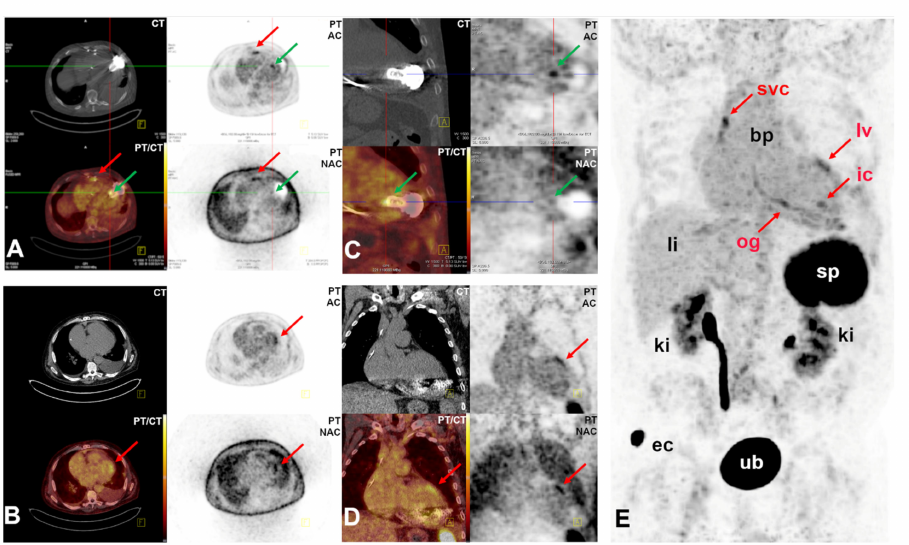
Figure 2. [ 18 F]GP1 PET/CT imaging findings of patient #2 with small thrombi in inflow cannula and outflow graft of the LVAD and residuum of thrombus adherent to the anterior wall. ( A ) Axial views of CT, PET attenuation corrected (PT AC), PET non-attenuation corrected (PT NAC) and corresponding fusion PET/CT images showing the small thrombi in inflow cannula (SUVmax 4.9, green arrows) and outflow graft (SUVmax 4.3, red arrows). ( B ) Axial views CT, PT AC, PT NAC and PT/CT images showing the small thrombus adherent to the anterior wall (SUVmax 5.5, red arrows). ( C ) Coronal views of CT, PT AC, PT NAC and PT/CT images showing the small thrombus in the inflow cannula (red arrows). ( D ) Coronal views of CT, PT AC, PT NAC and PT/CT images showing the small thrombus adherent to the anterior wall. ( E ) Maximum intensity projection (MIP) of [ 18 F]GP1 PET showing physiologic tracer distribution within visceral organs and visible tracer accumulation in inflow cannula (ic) and outflow graft (og) of the LVAD, adherent to the anterior wall (lv) and in the superior vena cava, located at the tip of central venous catheter (SUV max